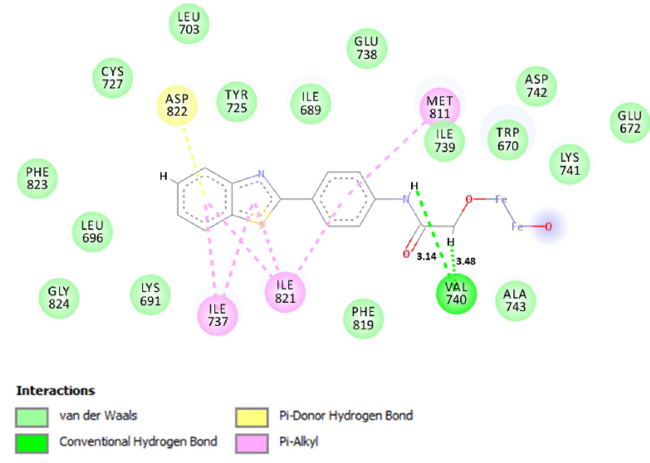
Figure 10. Interactions performed in molecular docking simulation with the ABT/ δ -FeOOH– PI3K system.